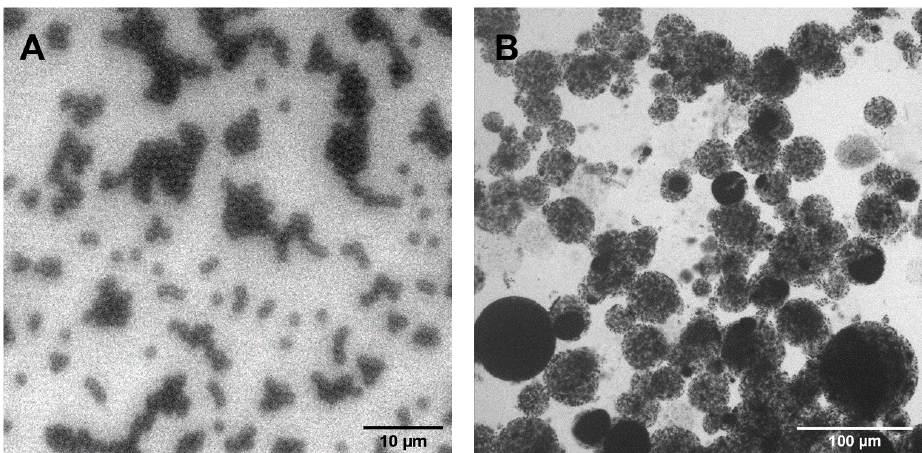
Figure 3. Microscope images of magnetic beads: a 10-fold diluted solution of Dynabeads (( A ); scale bar 10 µm) and a solution 2-fold diluted solution of Cu-NTA (( B ); scale bar 100